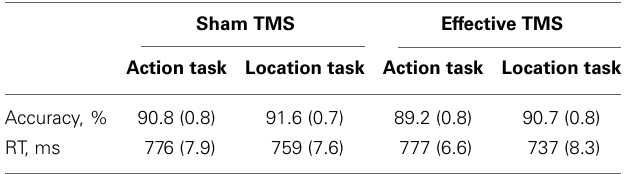
Table 1 | Accuracy and RT for the action task and the location task, during sham TMS and effective